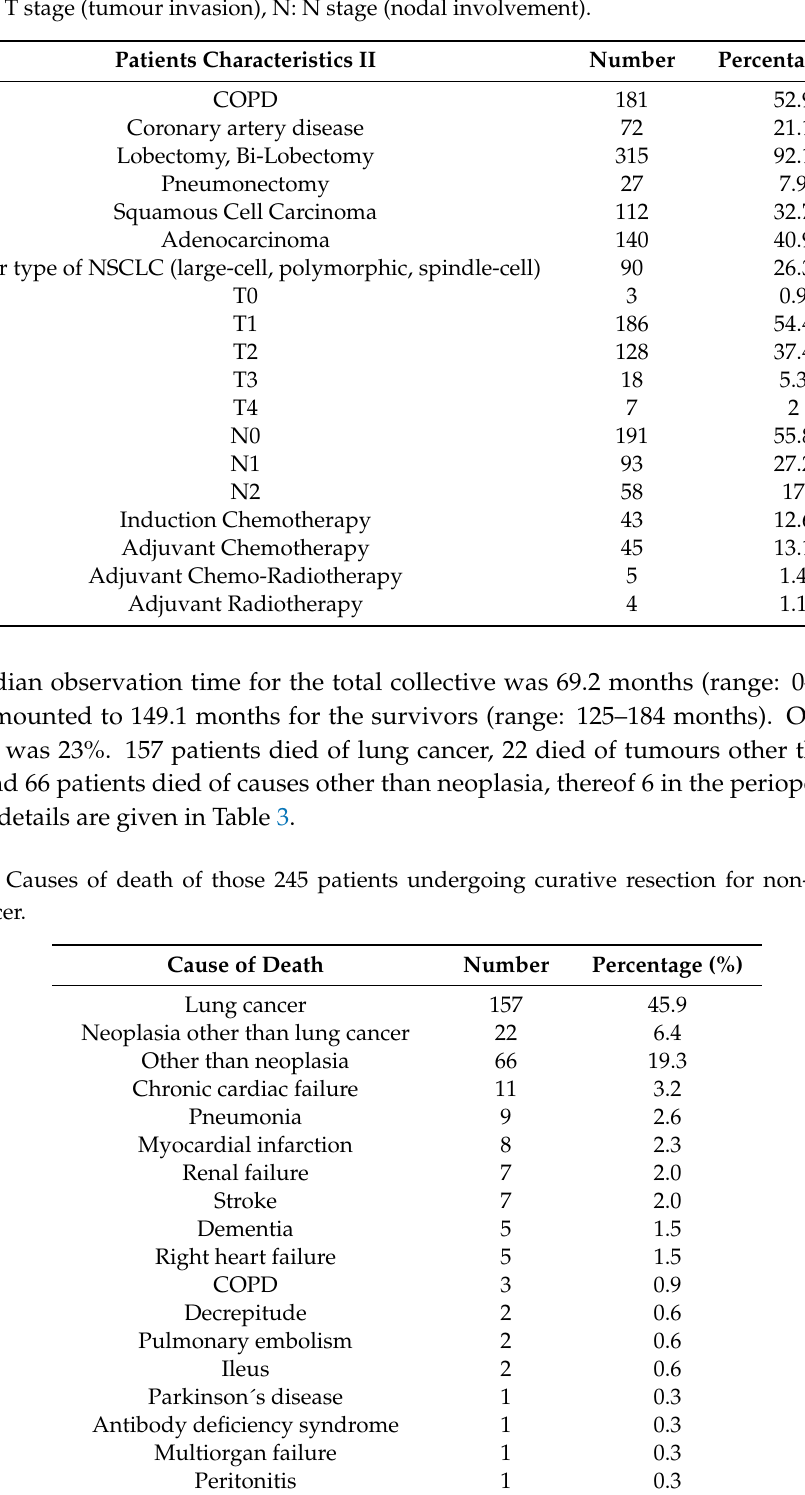
Abbreviation: COPD: Chronic obstructive pulmonary